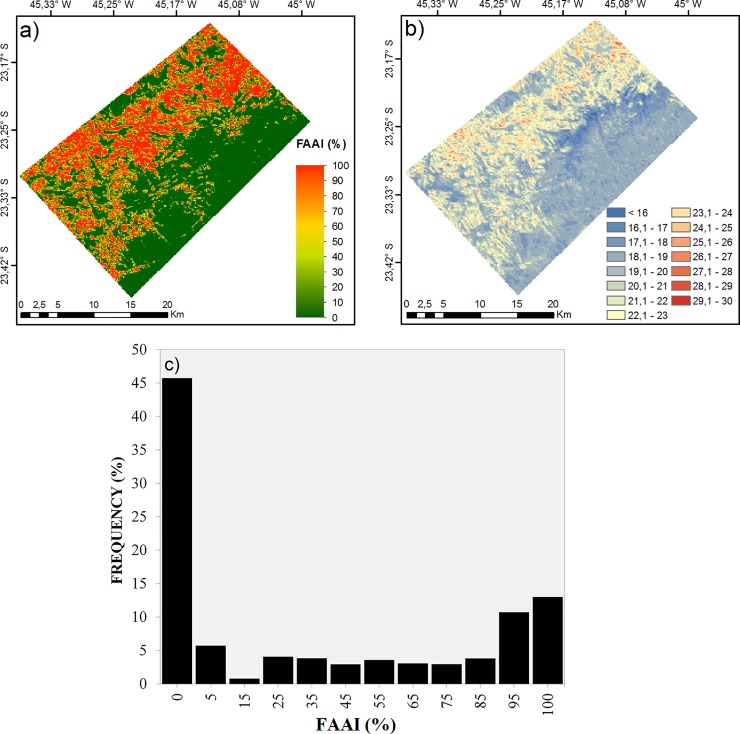
(a) Average FAAI at a resolution of 120 m (%). (b) Average LST at a resolution of 120 m (°C). (c) Histogram of FAAI occurrence by intervals of 0% to 5%, and then from 5% to 95% in 10% increments, and finally from 95% to 100%.